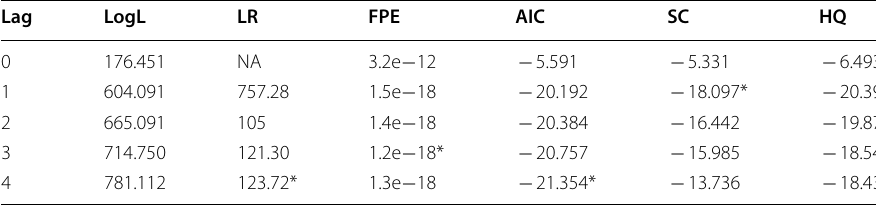
Sourc e Authors’ calculations * Indicates lag order selected by the criterion Table 6 ARDL bounds test analysis